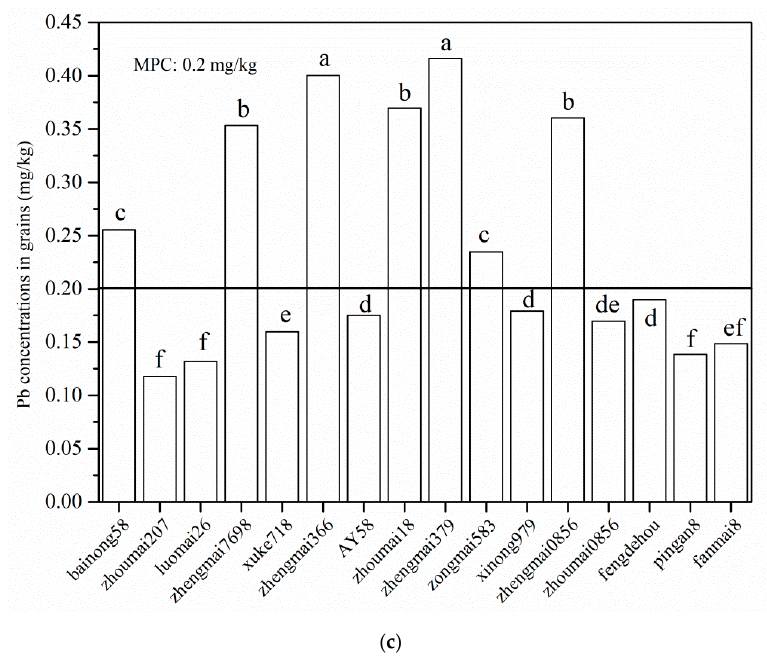
Figure 2. Concentrations of As ( a ), Cd ( b ), and Pb ( c ) in the grains of 16 wheat cultivars. Different letters indicate significant differences in mean values at p < 0.05.